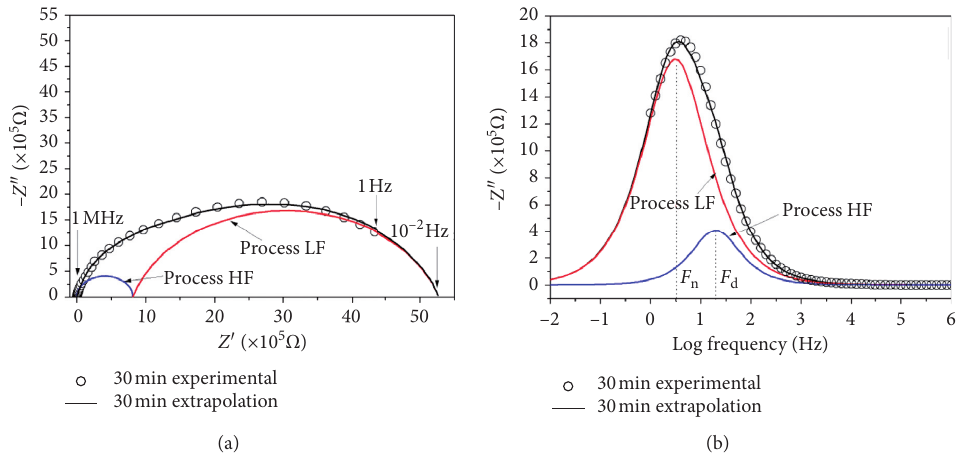
Figure 5: (a) Nyquist and (b) bode plots for the ITO/ZnO/CdS/CuO:Co/Ag at t � 30min. Deconvolution: low frequency (red color) and high frequency (blue